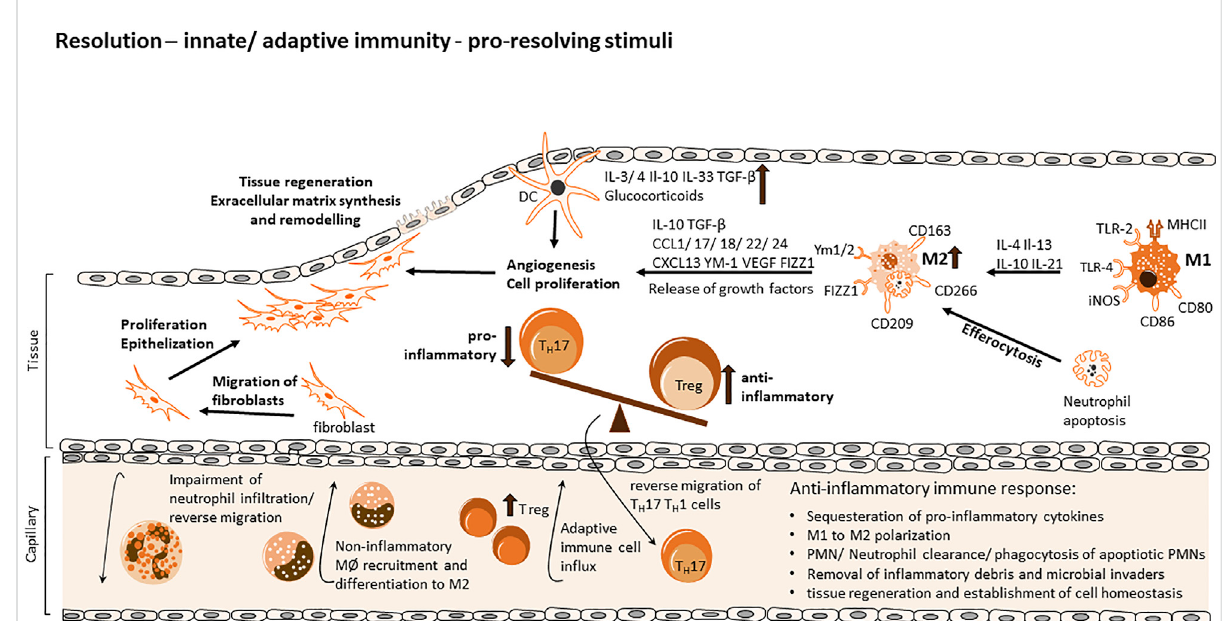
FIGURE 2 Cellular and molecular processes of in fl ammation and resolution via innate and adaptive immune response. During the evolution of the in fl ammatory response, various mechanisms facilitate a shift to a resolving cell-program phenotype via generation of anti-in fl ammatory and therefore pro-resolving mediators, creating a favorable environment for the resolution phase and return to tissue homeostasis and regeneration. Diverse mechanisms consist of the sequestration of pro-in fl ammatory cytokines, proteolysis of chemokines and degradation via NETs (neutrophilextracellulartraps)therebyre-modellingchemokinegradientsandimpairingthein fl uxofneutrophils.Apoptoticneutrophilsreleasepro- resolving mediators, leadingto an inhibition ofcontinued neutrophil in fi ltration anda non-in fl ammatory monocyte recruitmentupondifferentiation to M2 macrophages. Neutrophils further promote their dismissal via fi nd me and eat me signals, which attract scavengers and allow identi fi cation of the apoptotic cell. Anti-in fl ammatory mediators facilitate the polarization of M1 macrophages towards a resolution-phase phenotype, promoting efferocytosis and the expression/release of growth factors for tissue regeneration, enable the migration of fi broblasts, extracellular matrix synthesis and the remodeling of tissue to a fi nal re-establishment of cell homeostasis. The in fl ux of Tregs from the adaptive immune response re-program in fl ammatory responses and mediators and upregulation of anti-in fl ammatory Tregs in contrast to Th17 cells as well as their reverse migration promote resolution